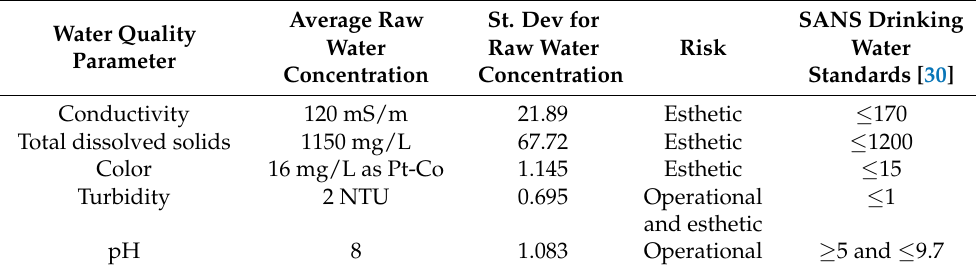
Table 2. Results showing average values of physicochemical determinants of raw water (n = 780) used in filter performance tests with reference to SANS for drinking water quality.